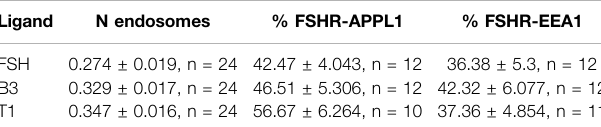
TABLE 2 | Co-localization of FSHR with endosomal markers via